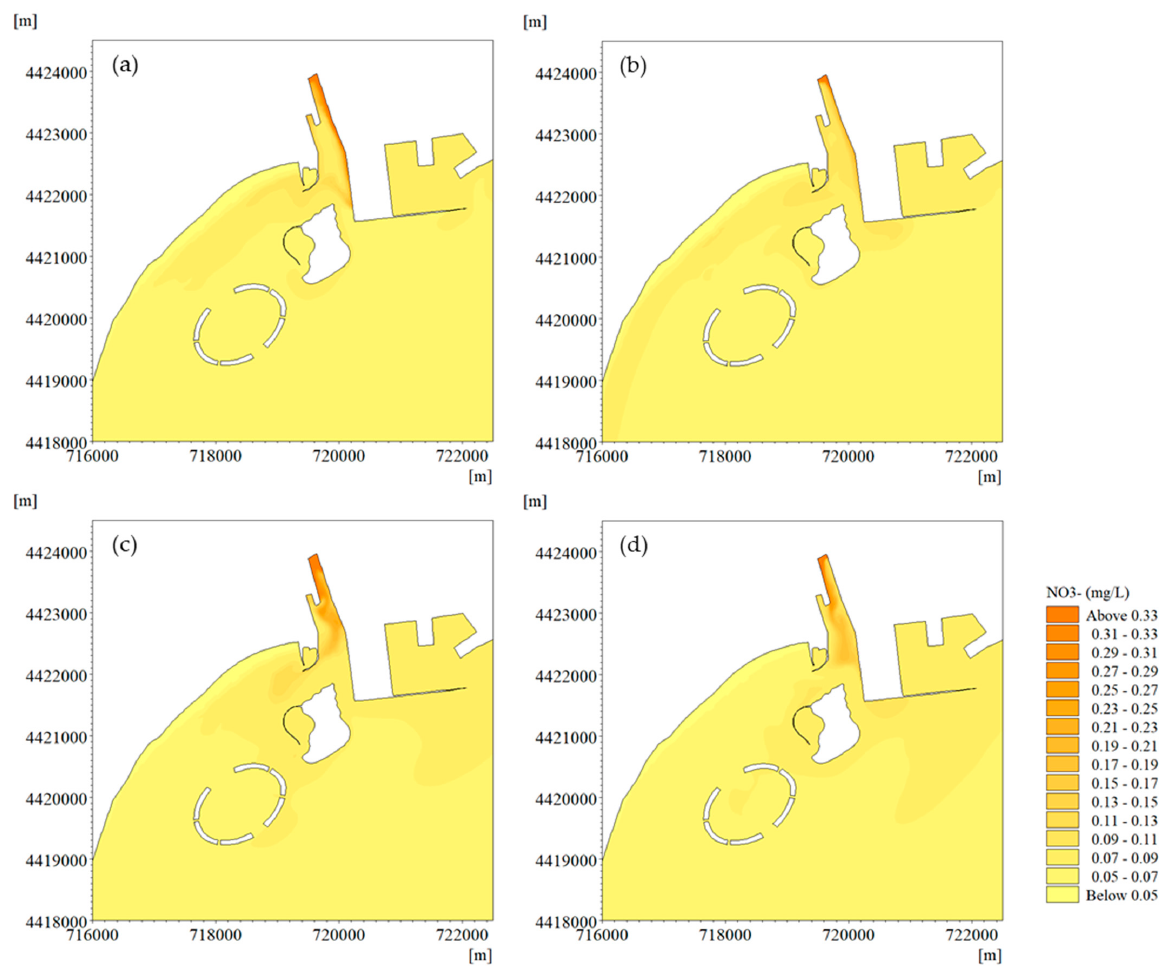
Figure 10. Distributions of NO 3 − at ( a ) the peak flood, ( b ) the peak ebb during a typical neap tidal period and ( c ) the peak flood, ( d ) the peak ebb during a typical spring tidal period, under the current construction conditions.